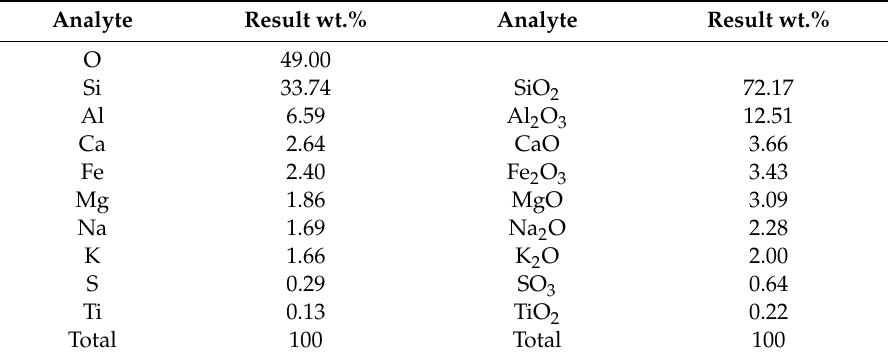
Table 2. XRF analysis of the FD